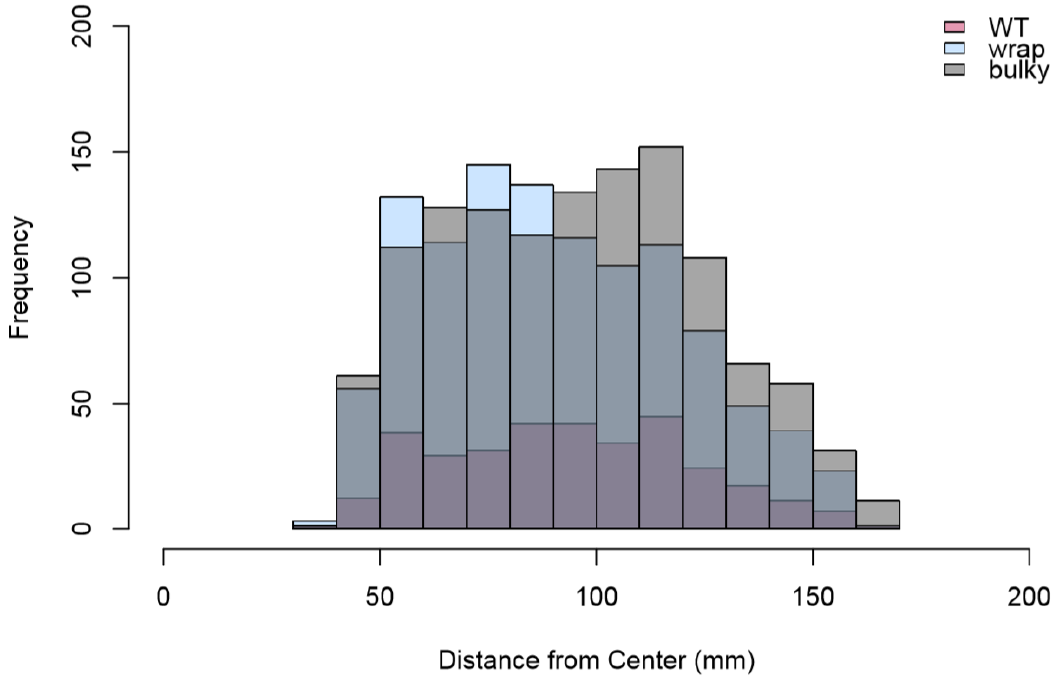
Figure 10. Histogram of distances in mm to the center of each colony from the center of each nitrocellulose membrane. Total colony counts combining two replicates are as follows: WT = 334, Wrap = 1113, Bulky = 1252. Results of two-sample Kolmogorov–Smirnov tests for each pair are as follows: WT–Wrap D = 0.090973, p = 0.02849; Wrap–Bulky D = 0.09624, p = 3.702 × 10 − 5 ; WT–Bulky D = 0.055465, p =